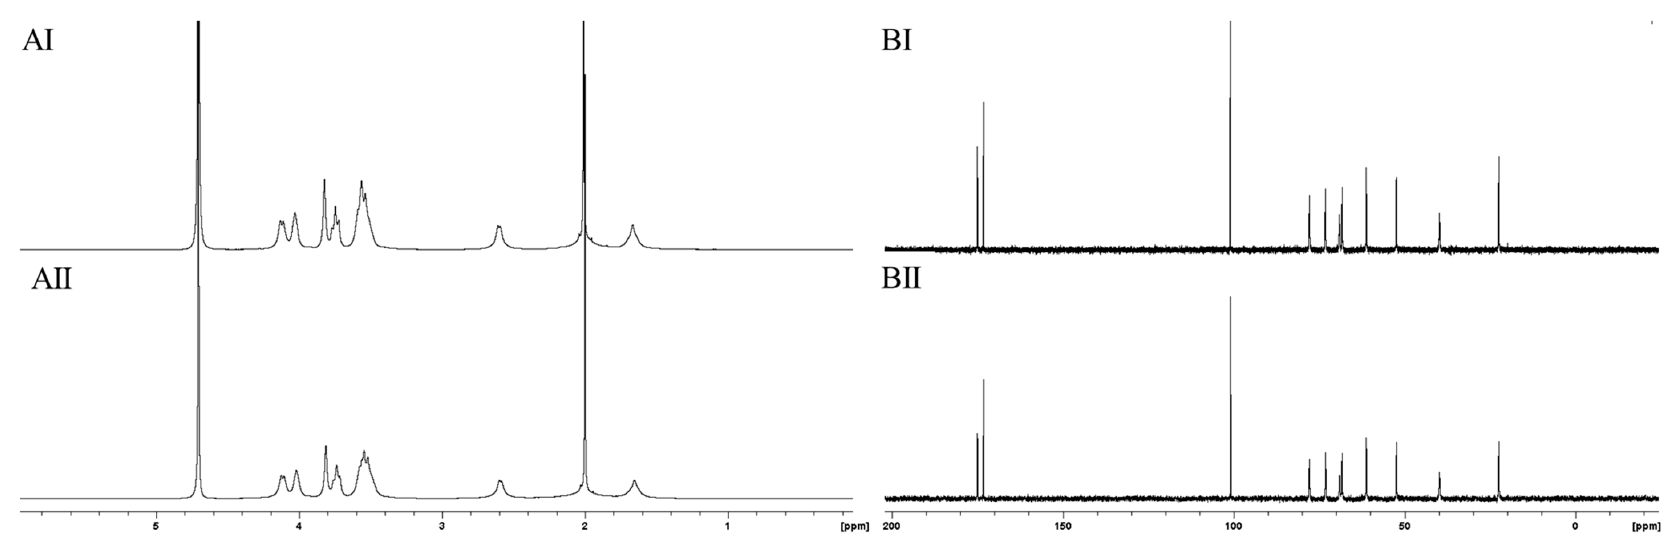
Figure 6. Comparison of the 1 H- ( A ) and 13 C- ( B ) NMR spectra of LC polySia ( I ) and hydrolyzed polySia ( II ). Hydrolysis was performed for 3 h at 90 °C and polySia was subsequently collected with an AEX membrane adsorber (SartobindQ 75 mL). The spectra show no changes of the molecular structure.